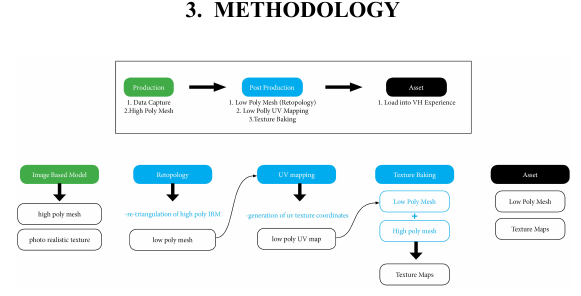
Figure 5. Workflow diagram for producing game resolution assets